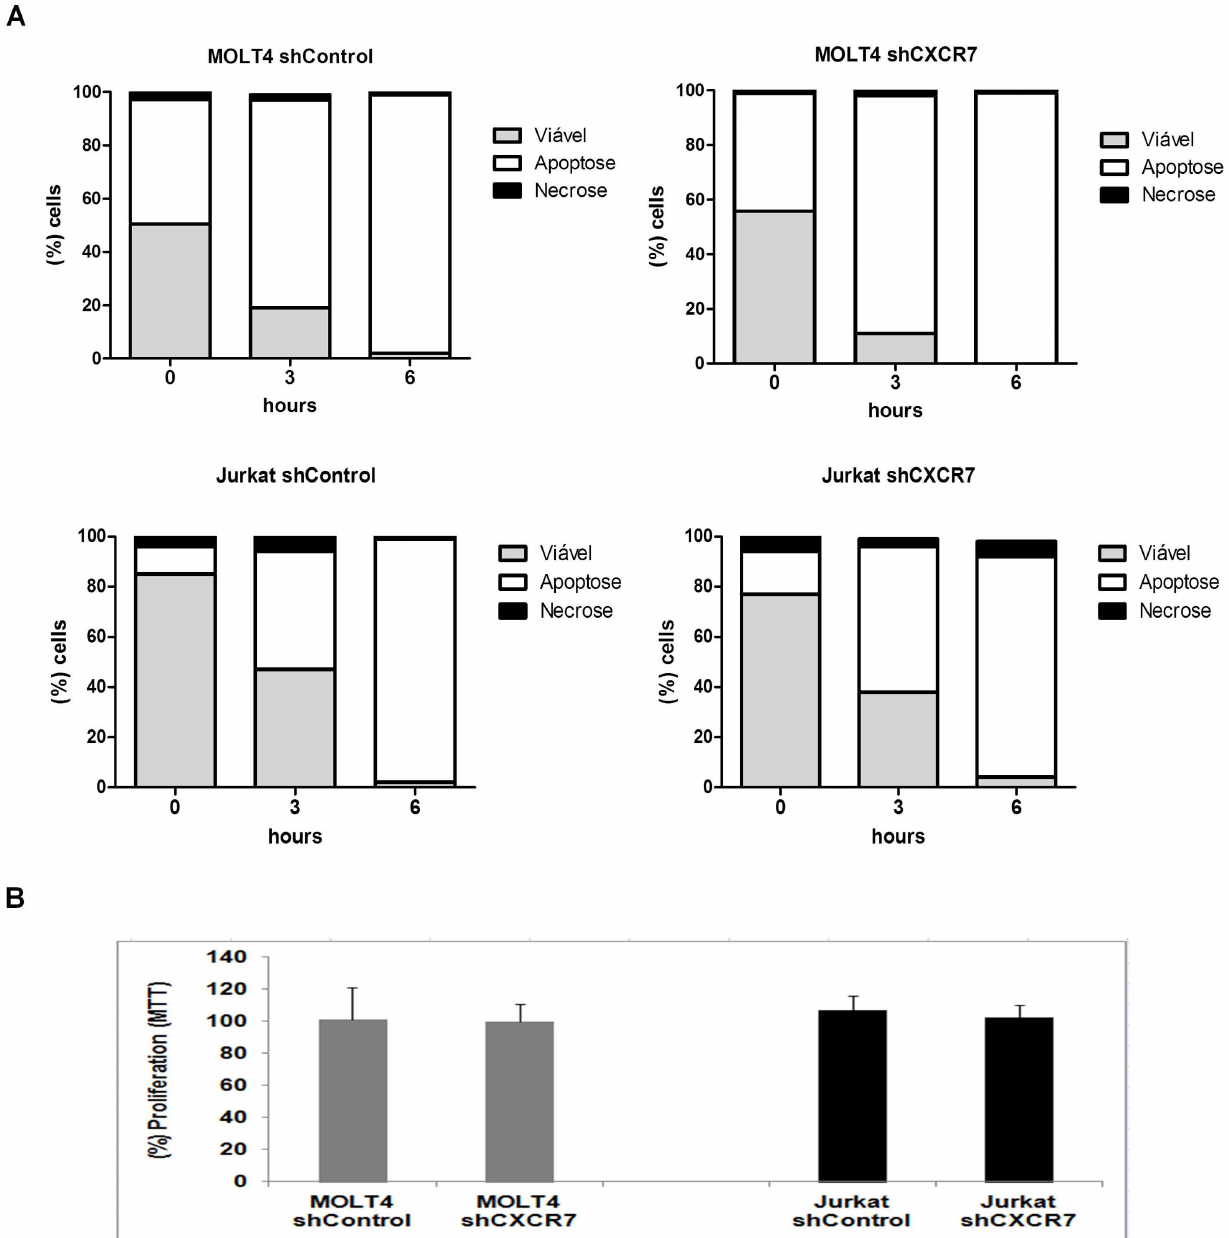
Figure 8. CXCR7 silencing did not modify apoptosis and proliferation of MOLT4 and Jurkat cells. To evaluate whether CXCR7 is important in the process of cell death, control and inhibited CXCR7 cells were exposed to 10 J/m 2 UV for different periods of time (0, 3, and 6 hours) and apoptosis was detected by flow cytometry using Annexin V/PI staining method. Cell proliferation was determined by MTT assay. Results are shown as mean 6 SD of six replicates. No differences in apoptosis rate (A) or proliferation (B) were observed in MOLT4 and Jurkat cell lines. RPMI 10% FBS. In brief, 10 m L of a 5 mg/mL solution of MTT were added to the wells and incubated at 37 u C for 4 hours. The A total of 5 6 10 5 cells of MOLT4 (shControl and shCXCR7) reaction was stopped by using 100 m L of 0.1 N HCl in anhydrous and Jurkat (shControl and shCXCR7) were seeded on 6-well isopropanol. Cell growth was evaluated by measuring the plates and were exposed to a dose of 10 J/m 2 for different periods absorbance at 570 nm, using an automated plate reader. All of time (0, 3 and 6 hours). Cells were then washed twice with ice conditions were tested in six replicates. cold PBS and resuspended in binding buffer containing 1 m g/mL PI and 1 m g/mL FITC labeled annexin-V. All specimens were analyzed on a FACSCalibur after incubation for 15 minutes at